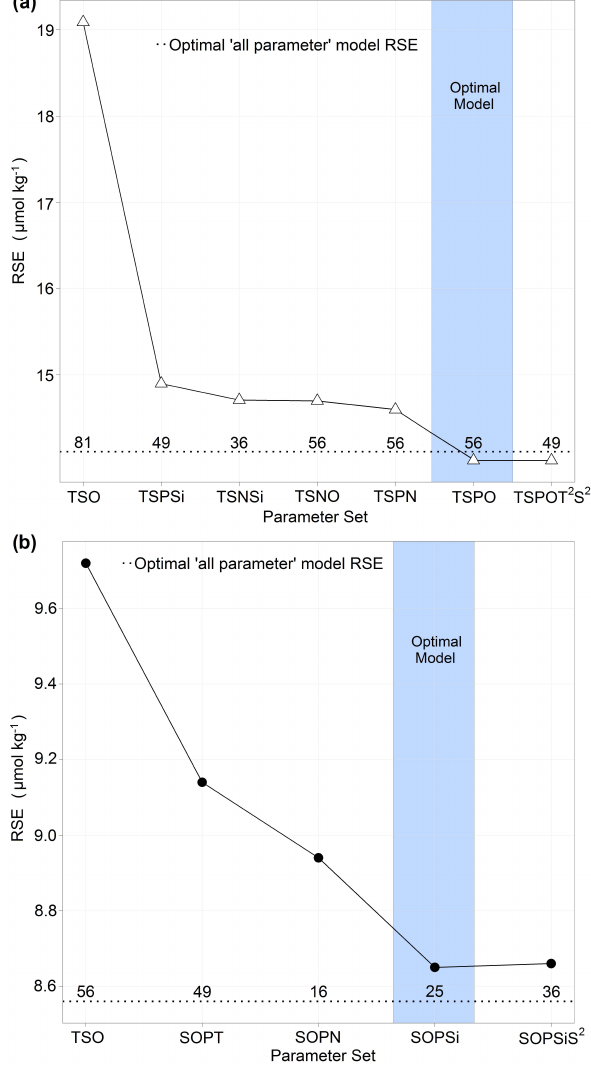
T and (b) A T SOMLO models. Numbers above the line represent the optimal number of neurons. Parameter set represents the combination of parameters used to train and test the SOMLO model, where O represents dissolved